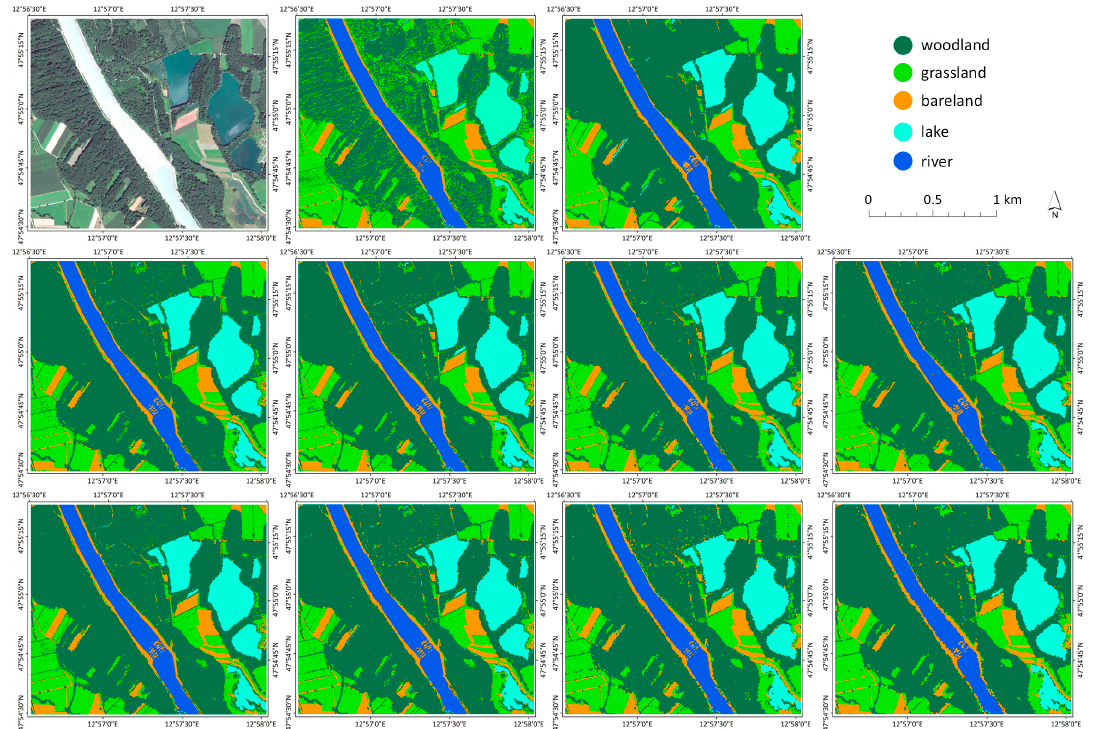
Figure 9. Random forest classification results for T3: ( a ) original WorldView-2 RGB image, ( b ) pixel-based classification, ( c ) multiresolution segmentation classification, ( d – g ) SLIC superpixels classification of 5 × 5, 10 × 10, 15 × 15 and 20 × 20 pixels initial size of superpixels and ( h – k ) SLICO superpixels classification of 5 × 5, 10 × 10, 15 × 15 and 20 × 20 pixels initial size of superpixels.